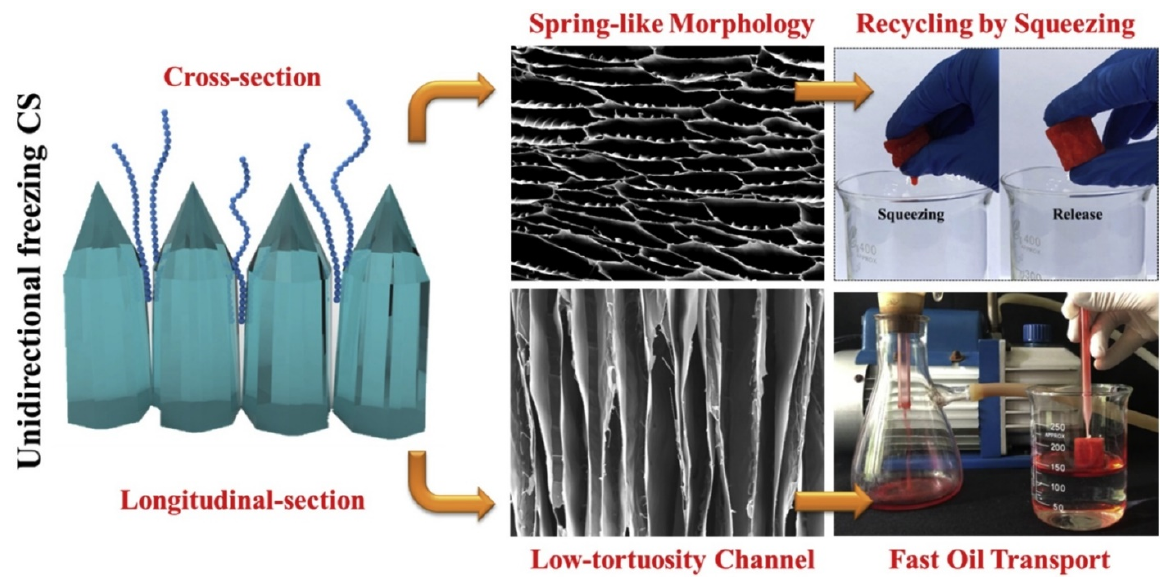
Figure 8. Schematic of unidirectional freezing ( left ), SEM images of a CS-MTMS aerogel composite specimen along transverse and longitudinal cross sections ( middle ), and the photos showing oil removal using the aerogel composite ( right ). Reproduced with permission from [17], ©2019 Elsevier